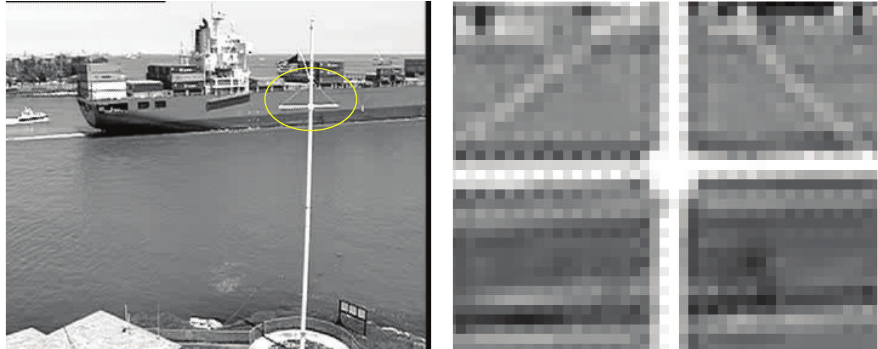
Figure 4: Reconstructed frame when one spatial description is